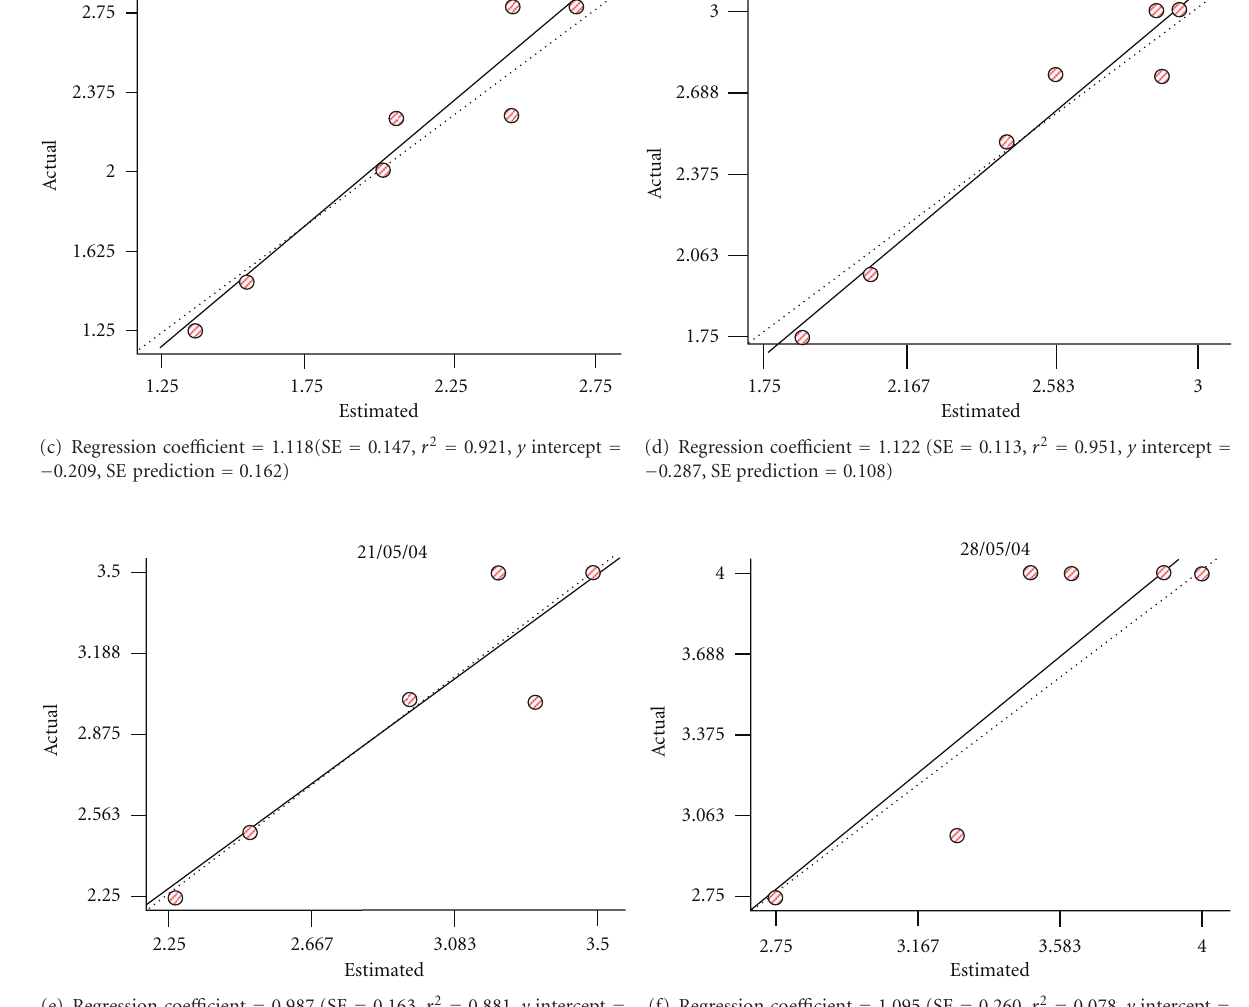
Figure 3: Cross-validation analyses (variograms) obtained for year